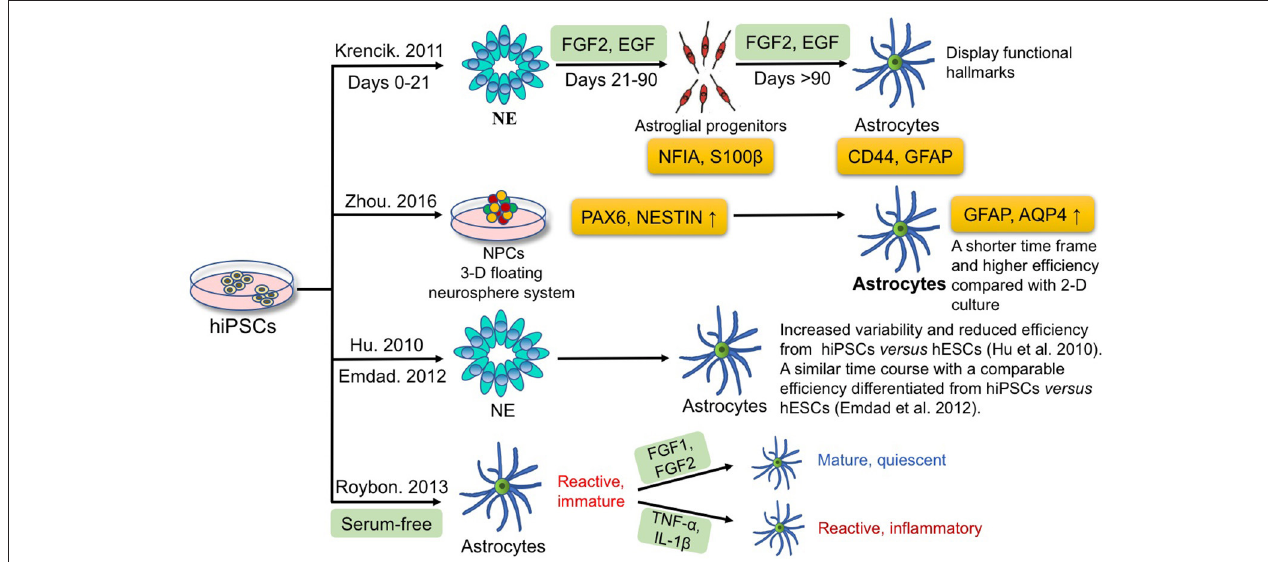
FIGURE 2 | Current approaches for deriving astrocytes from hiPSCs . Krencik et al. produced astroglial progenitors and immature astrocytes differentiated from hiPSCs through a 6-month process in the presence of FGF2 and EGF. Zhou et al. employed a 3-D floating neurosphere system to increase the efficiency and to shorten the time frame of astrocytes differentiation. Hu et al. and Emdad et al. compared the time course, variability and efficiency using hiPSCs vs. hESCs for differentiation into astrocytes. Roybon et al. reported that FGF1 or FGF2 can promote maturation to a quiescence state without triggering inflammation; yet TNF- α and IL-1 β have opposite effects and induce a reactive inflammatory state of